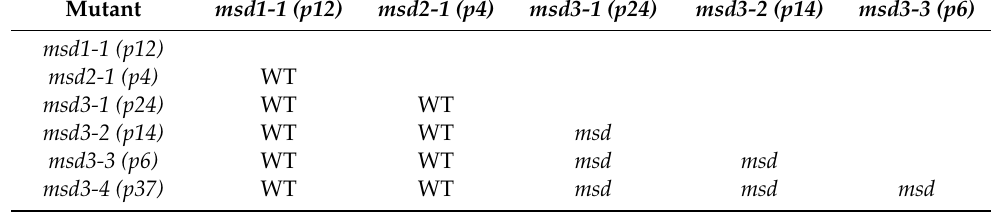
Table 1. Complementation tests between msd3 , msd2 , and msd1 mutants. The msd3 mutants were crossed to each other and to msd1-1 and msd2-1 mutants by hand emasculation and manual pollination. The panicle phenotypes of the F 1 plants were evaluated during the grain filling stage. Mutant